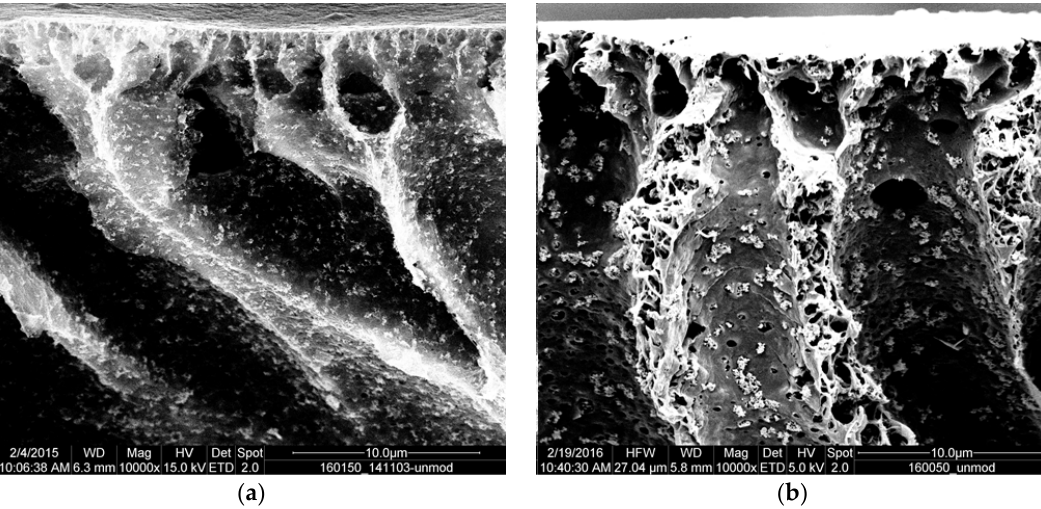
Figure 3. Nanofiller agglomerates in the cross-section of PVDF membranes obtained from dope solutions with 50% w/w(PVDF) zinc oxide. ( a ) with 1% PVP; ( b ) without PVP; magnification 10,000×.